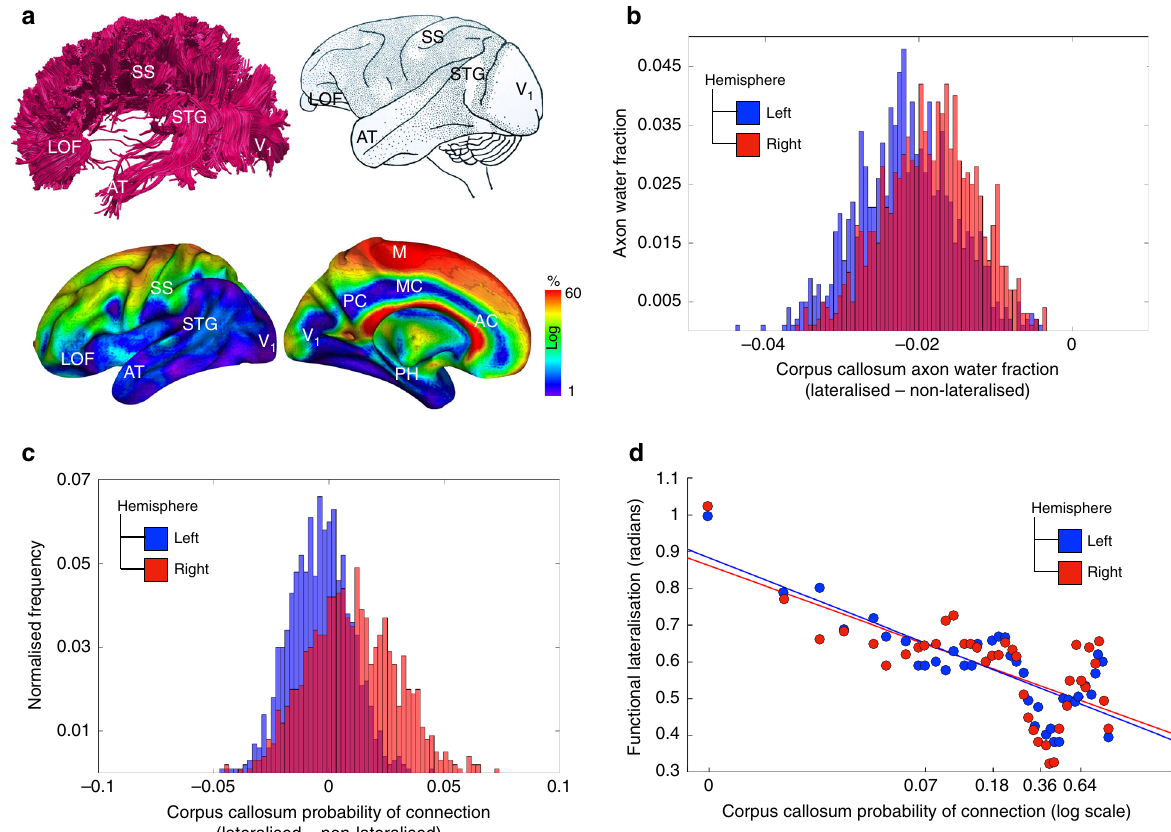
Fig. 3 Lateralisation and inter-hemispheric connectivity. a Tractography of the corpus callosum in a representative subject of our study (top left); cortical projection of the corpus callosum derived from axonal tracing in monkeys 31 (top right); cortical projections of the corpus callosum derived from tractography in the participants of our study (bottom). b Histogram of the difference between lateralised and non-lateralised regions in the corpus callosum axonal water fraction, averaged across participants. c Histogram of the difference between lateralised and non-lateralised regions in the corpus callosum probability of connection. The measure was calculated as the proportion of participants in which a connection exists between brain ’ s voxels and corpus callosum to the overall HCP sample size. d Dimensional relationship between the degree of functional lateralisation and the corpus callosum probability of connectivity. LOF lateral orbitofrontal cortex, SS somatosensory cortex, STG superior temporal gyrus, AT anterior temporal, V1 primary visual area, M primary motor area, PC posterior cingulate gyrus, MC middle cingulate gyrus, AC anterior cingulate gyrus, PH parahippocampal